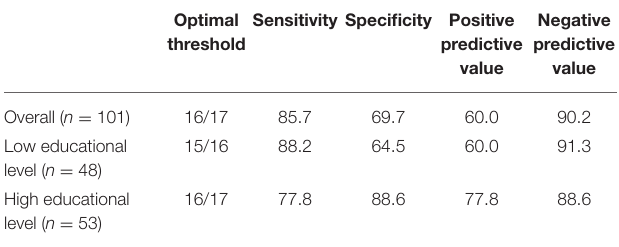
TABLE 2 | Optimal thresholds of T-MoCA and corresponding parameters in the overall population and educational level subgroups using CDR as the reference